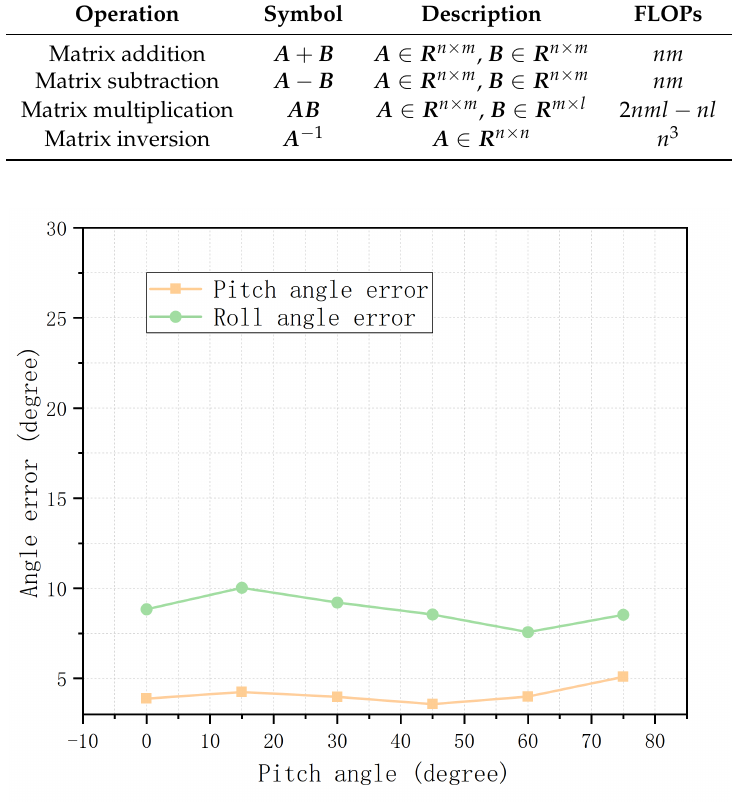
Figure 14. Posture error accuracy of the IVE-KF algorithm at different posture angles.